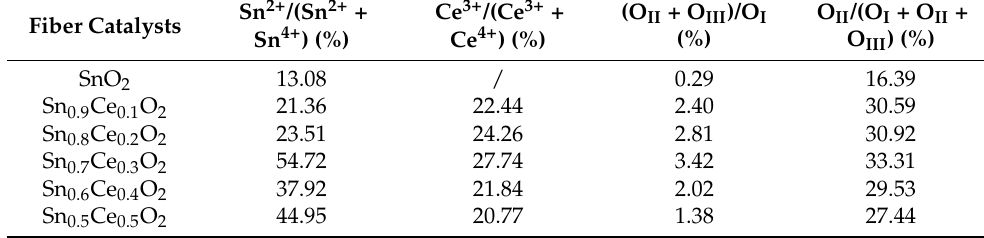
Figure 9. XPS spectra in the Sn 3d 5/2 region of the SnO 2 and Sn x Ce 1-x O 2 fiber catalysts.